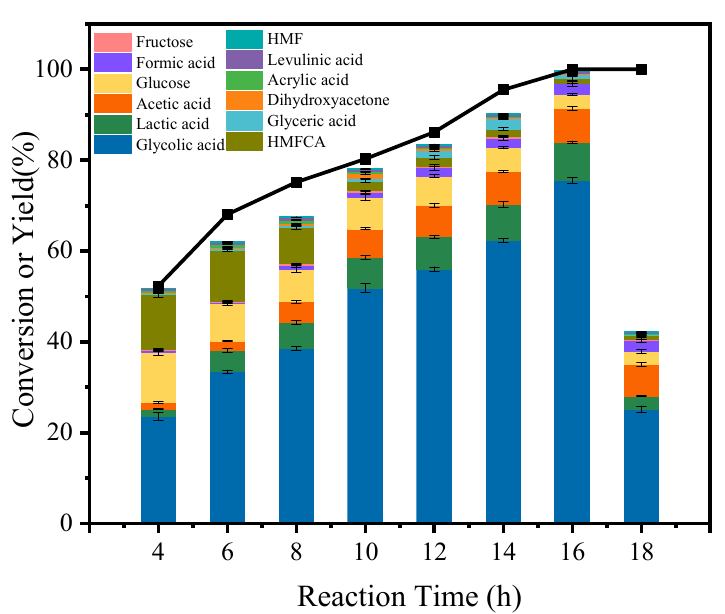
Figure 10. The effect of reaction time on the catalytic activity of Bi/ β -2 catalyst. Reaction conditions: cellulose 0.1 g, Bi/ β -2 0.08 g, H 2 O 12 mL, 180 °C, 2 MPa O 2 .